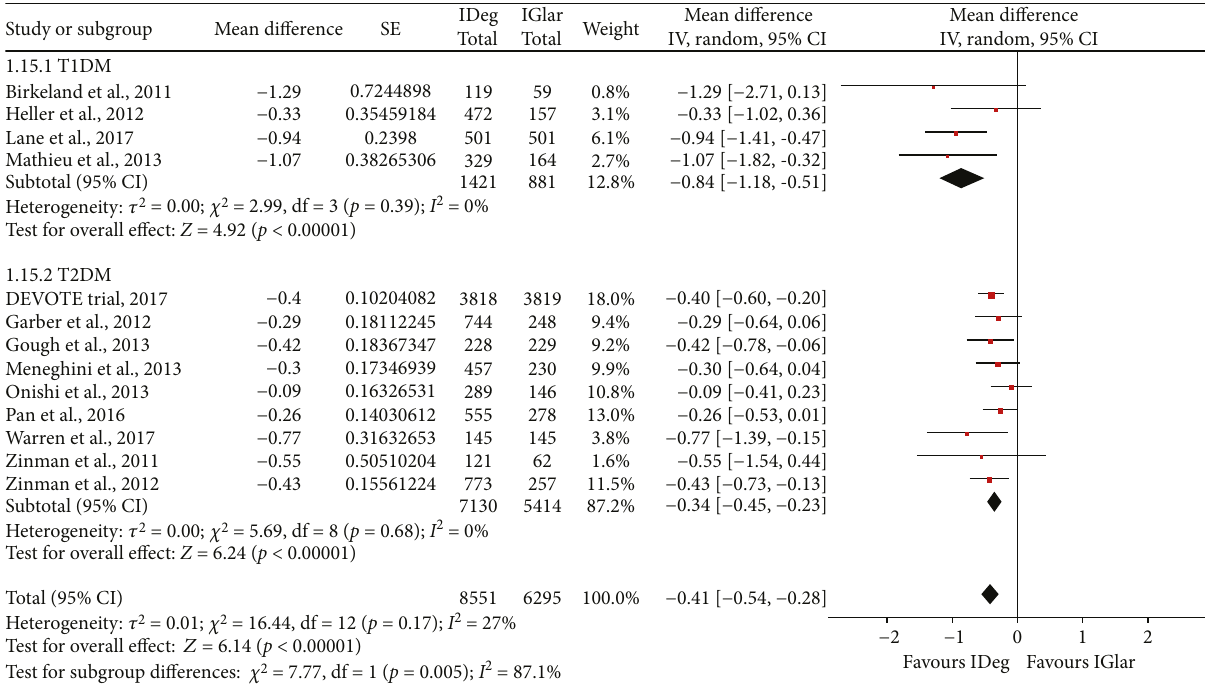
Figure 2: Mean di ff erence in the changes in the fasting plasma glucose (FPG) level between the IDeg and the IGlar groups: the abbreviations are the same as Figure